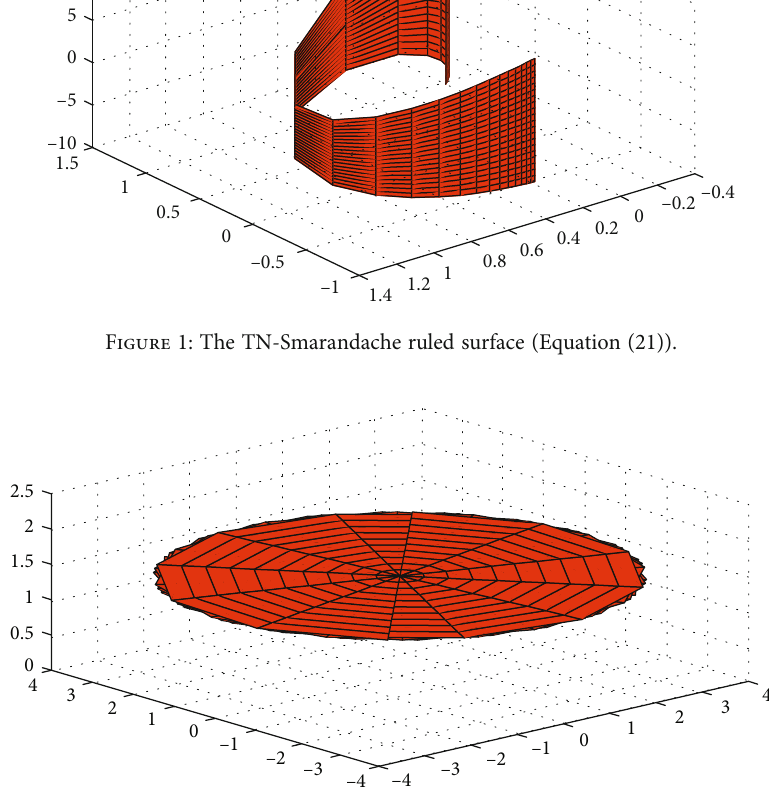
Figure 2: The TB-Smarandache ruled surface (Equation